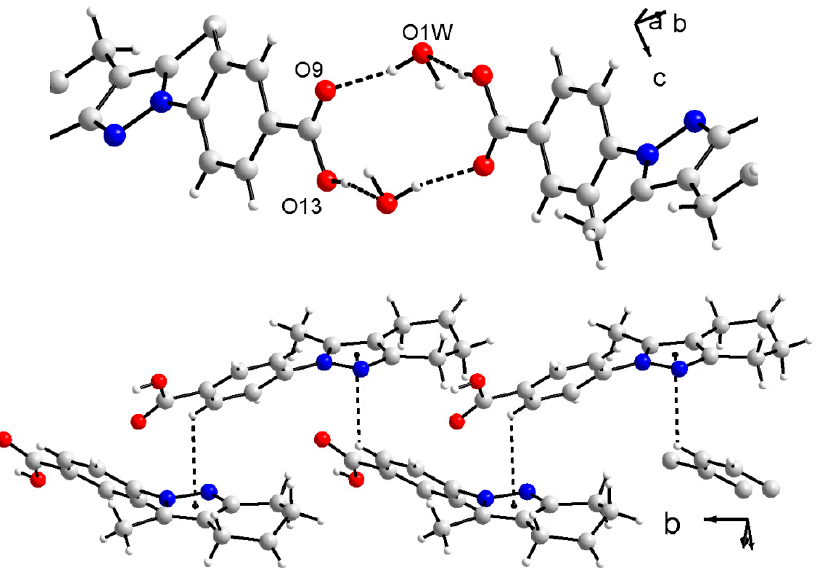
Figure 2. A view of partial packing of 3e showing: (top) the central core linking the components mediated by hydrogen bonds and (bottom) C-H... π (tetrahydroindazole) interactions. H-atoms are shown as small spheres of arbitrary radii. Dashed lines represent intermolecular interactions.